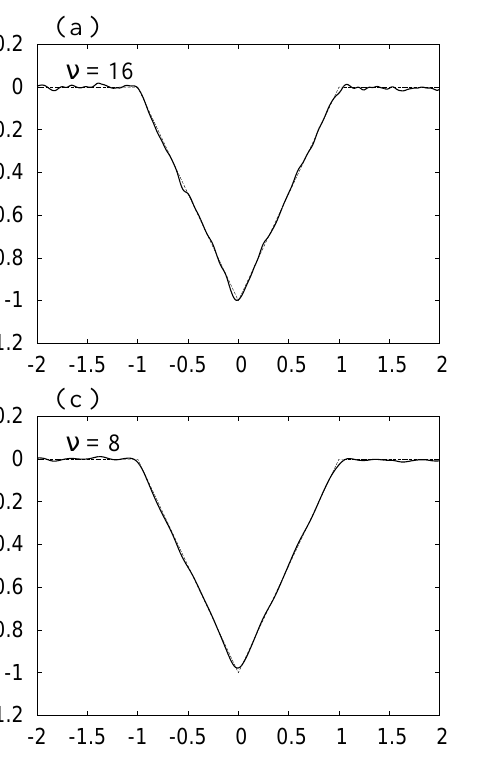
f ) ′ ( x ) and ( M ν 1 f ) ′ ( x ) ν 1